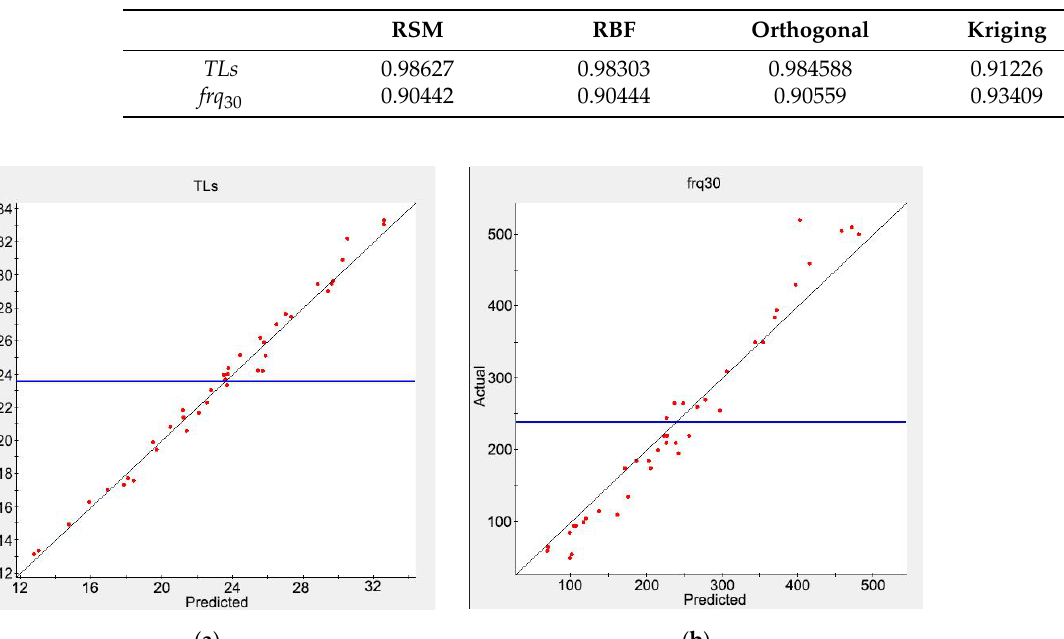
Table 1. R 2 values of the four approximate models of the optimization objectives.